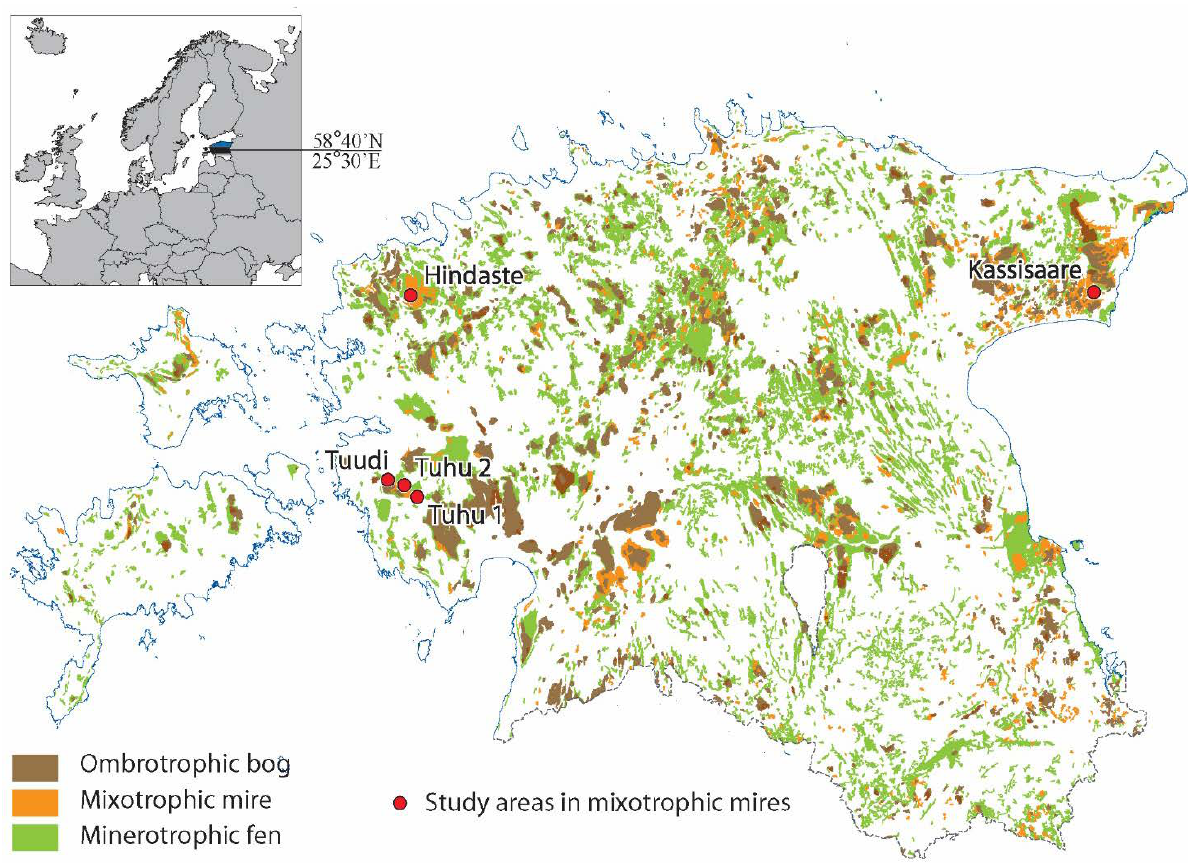
Figure 1. Locations of the study areas within